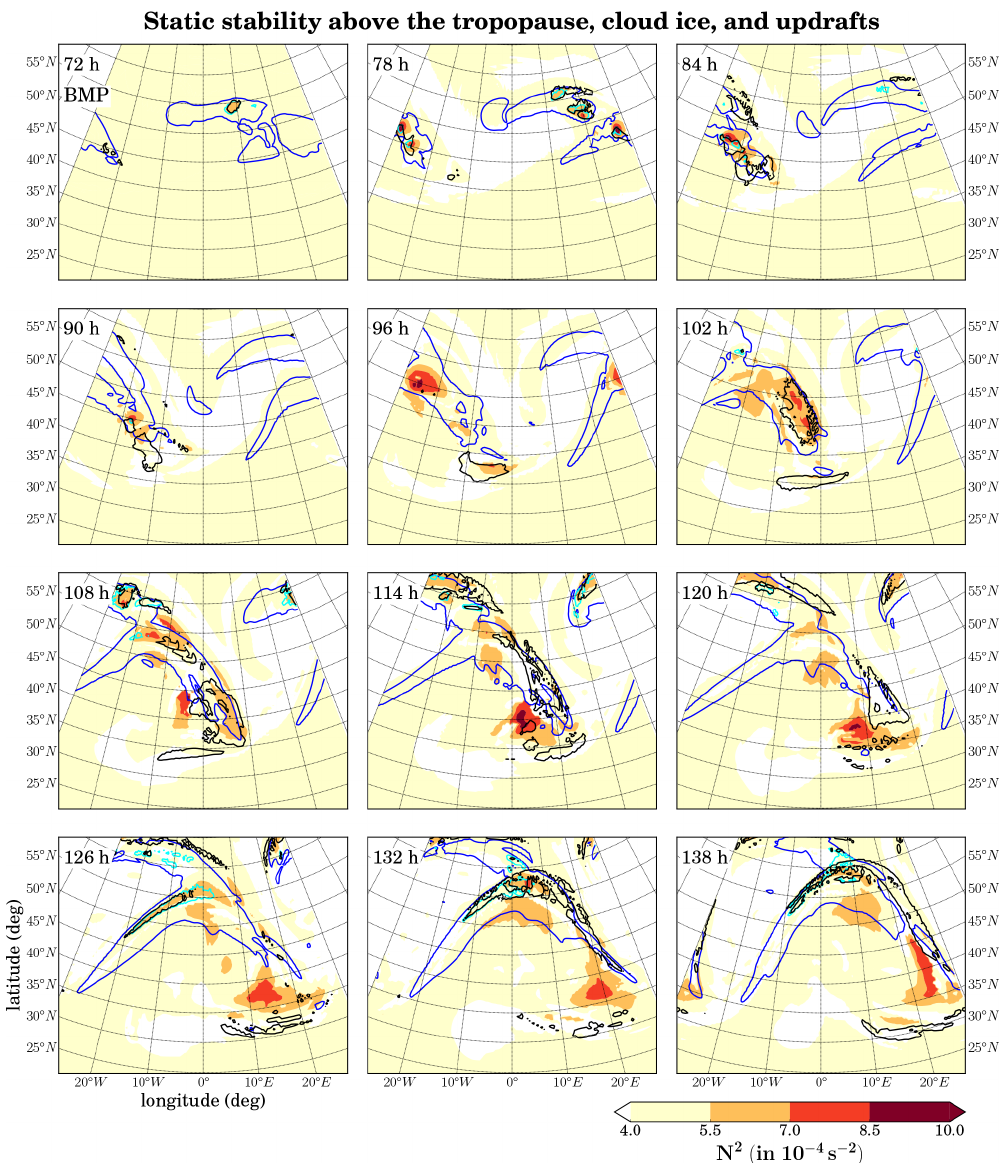
Figure 9. Static stability N 2 (color-coded, in 10 − 4 s − 2 ) above the thermal tropopause, (cid:49)z (black lines, in 2.5km), column integrated cloud- ice content tq i (blue lines, in 0.01kgm − 2 ), and tropopause close column integrated cloud-ice content tq i,tp (cyan lines, in 0.001kgm − 2 ). Tropopause close means the region between the thermal tropopause and 500m below. The distribution is shown for BMP between 72 and 138h after simulation start in a 6-hourly